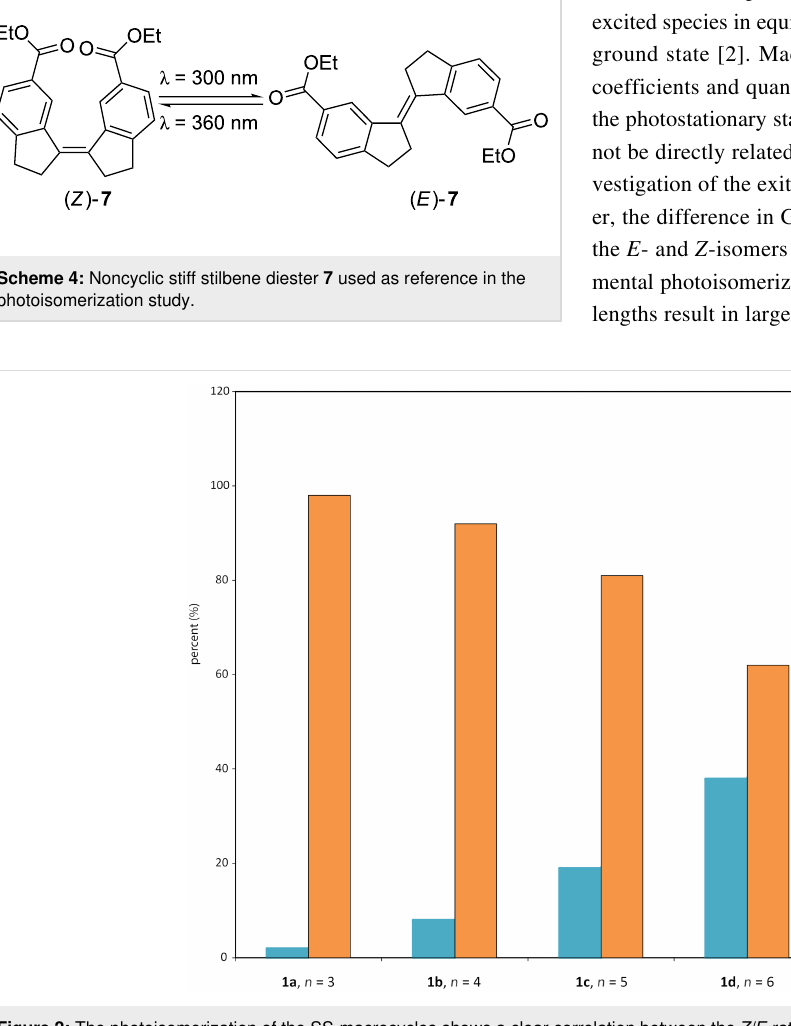
Figure 2: The photoisomerization of the SS-macrocycles shows a clear correlation between the Z / E ratio in the photostable mixture and the linker length. The non-cyclic SS-diester 7 is included as a reference.